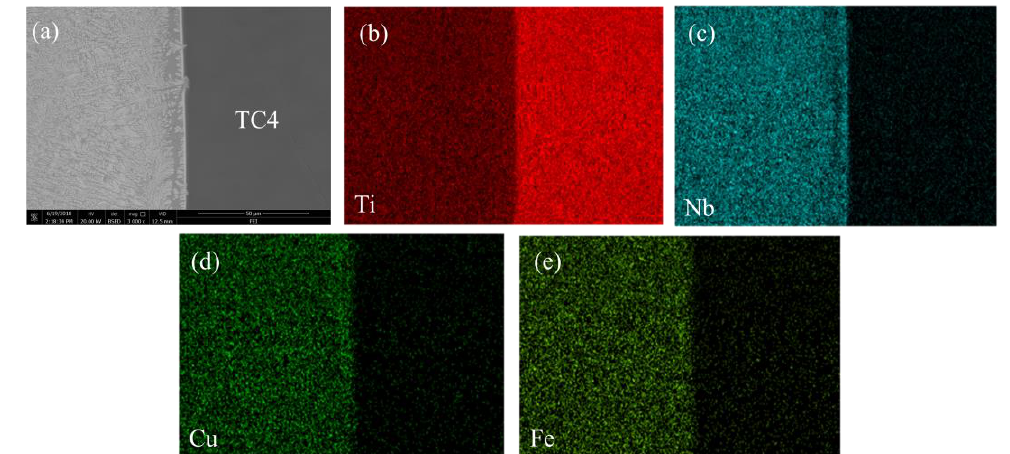
Figure 4. Distribution of the main elements in the weld metal of titanium alloy side of the welded joints at a welding speed of 6 mm/s (EBW-1), including ( a ) the back scatter electron (BSE) image, ( b ) the Ti map, ( c ) the Nb map, ( d ) the Cu map, and the ( e ) Fe map.